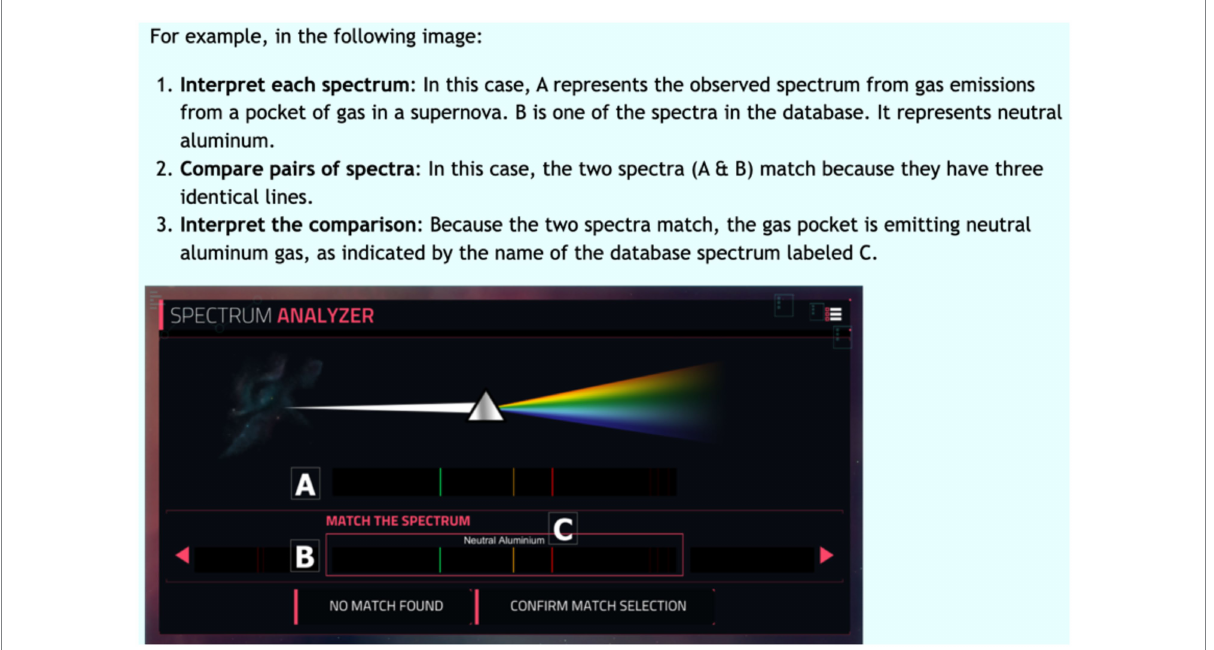
FIGURE 5 Example sense-making support: Students received a prompt that asked students to interpret each spectrum, compare pairs of spectra, and interpret the comparison, with a concrete example (in this case, with the Spectrum Analyzer within Mission